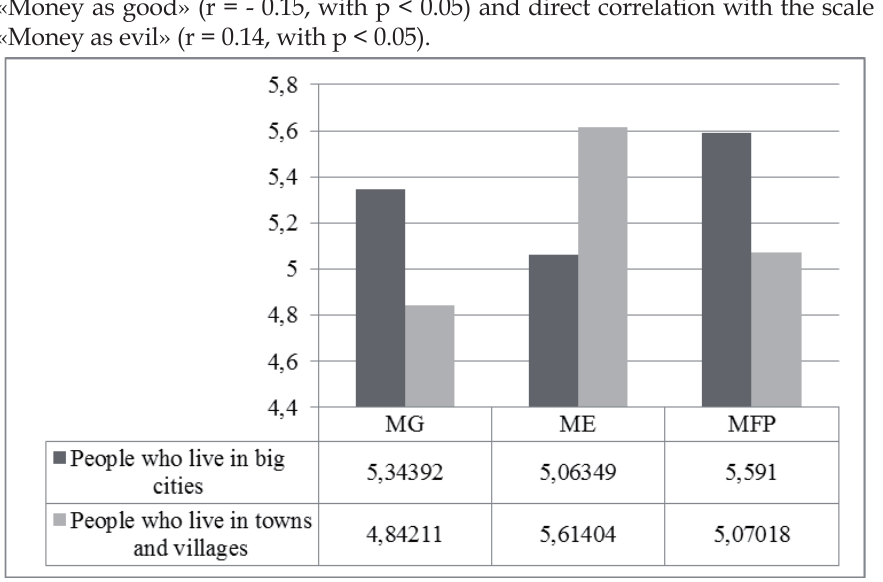
Figure 4. Statistically signi  cant differences in indicators of money attitudes in people with different places of